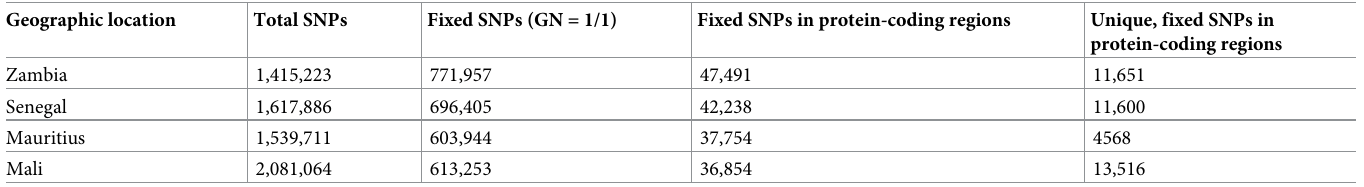
Table 3. Summary of the single nucleotide polymorphisms (SNPs) predicted in four representative Schistosoma haematobium males from Zambia, Senegal, Mauri- tius or Mali. Geographic